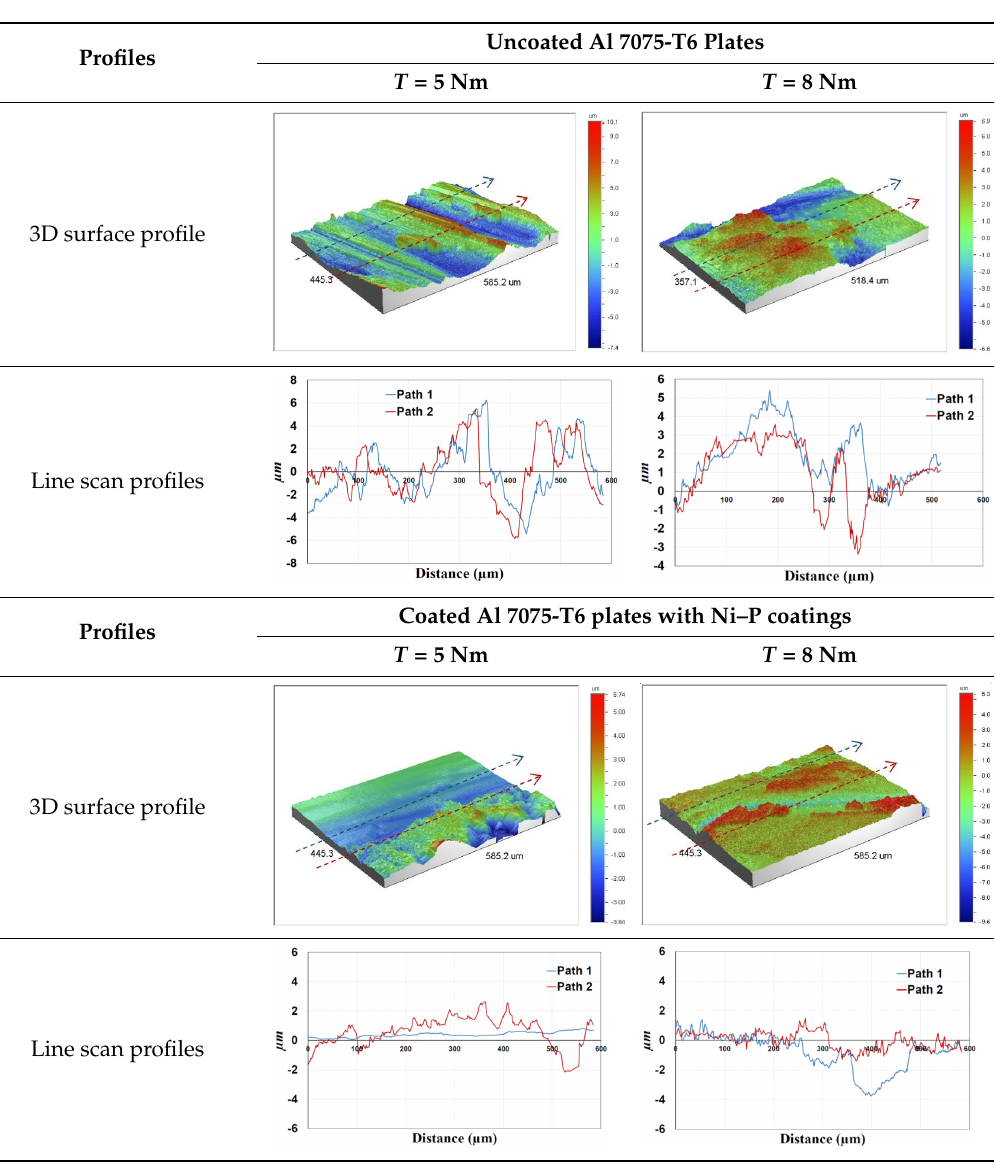
Table 2. 3D surface profile together with line scan profile for uncoated and coated aluminum plates clamped with 5 and 8 Nm that failed under maximum remote stress of S max = 80 MPa. Profiles